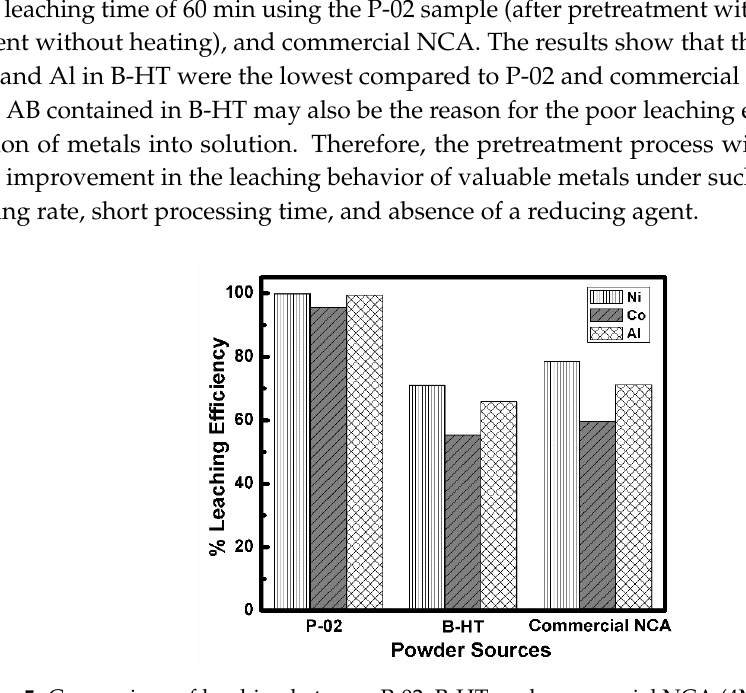
Figure 5. Comparison of leaching between P ‐ 02, B ‐ HT, and commercial NCA (4M HCl, 80 °C, 1 h).